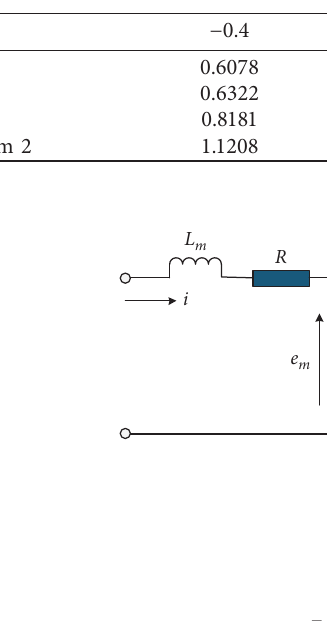
Table 1: Maximum allowable upper bounds for time delay Z